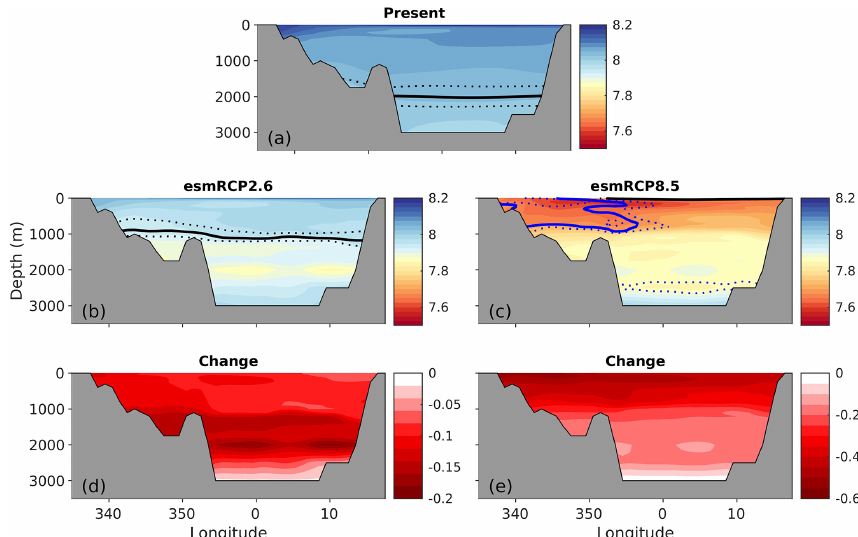
Figure 10. Zonal cross sections (at 70 ◦ N) of present (1996–2005) and future (2090–2099) pH under the emission-driven esmRCP2.6 and esmRCP8.5 scenarios, along with the change between the periods. The solid and dotted black lines show the saturation horizon of aragonite ( (cid:127) Ar = 1) with uncertainty ( σ field ). The solid and dotted blue lines show the corresponding for calcite ( (cid:127) Ca = 1).